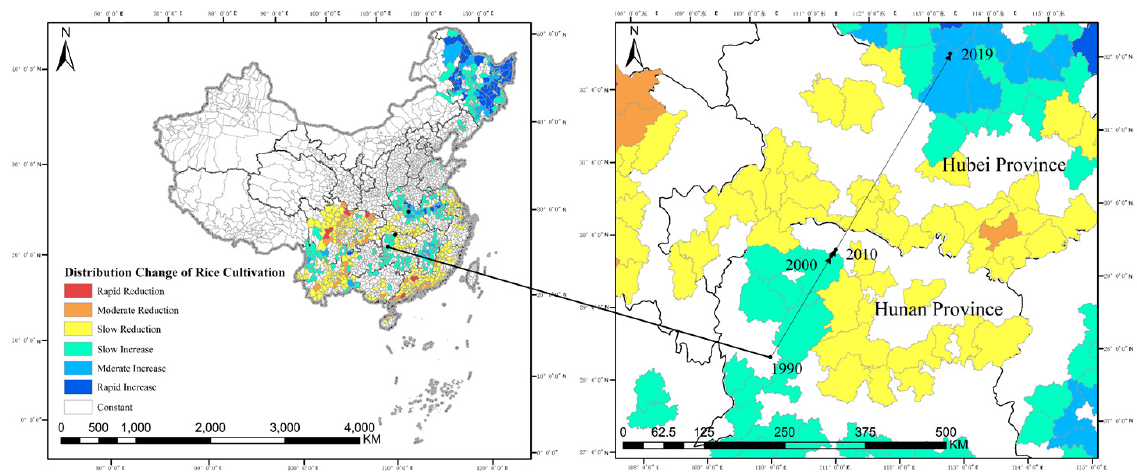
Figure 2. Change of patch area index and centre of gravity of rice production in China from 1990 to 2019.